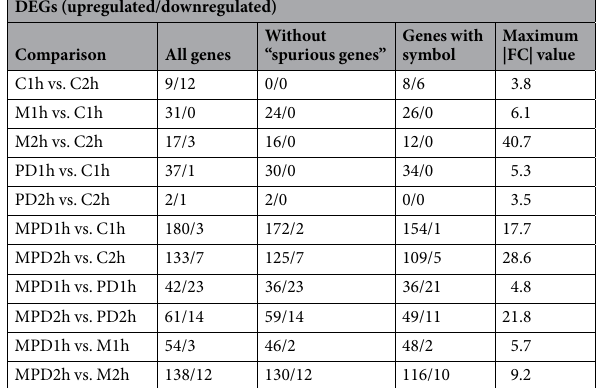
Table 1. Number of differentially expressed genes (DEGs) identified in the comparisons between groups. First column includes all the DEGs; second column shows the result of filtering out the “spurious genes”; third column indicates the genes that have an assigned gene symbol; forth column display the maximum absolute Fold Change (|FC|) value found in each comparison. Abbreviations: C, control; M, morphine; PD, PD168,077; MPD, morphine + PD168,077.